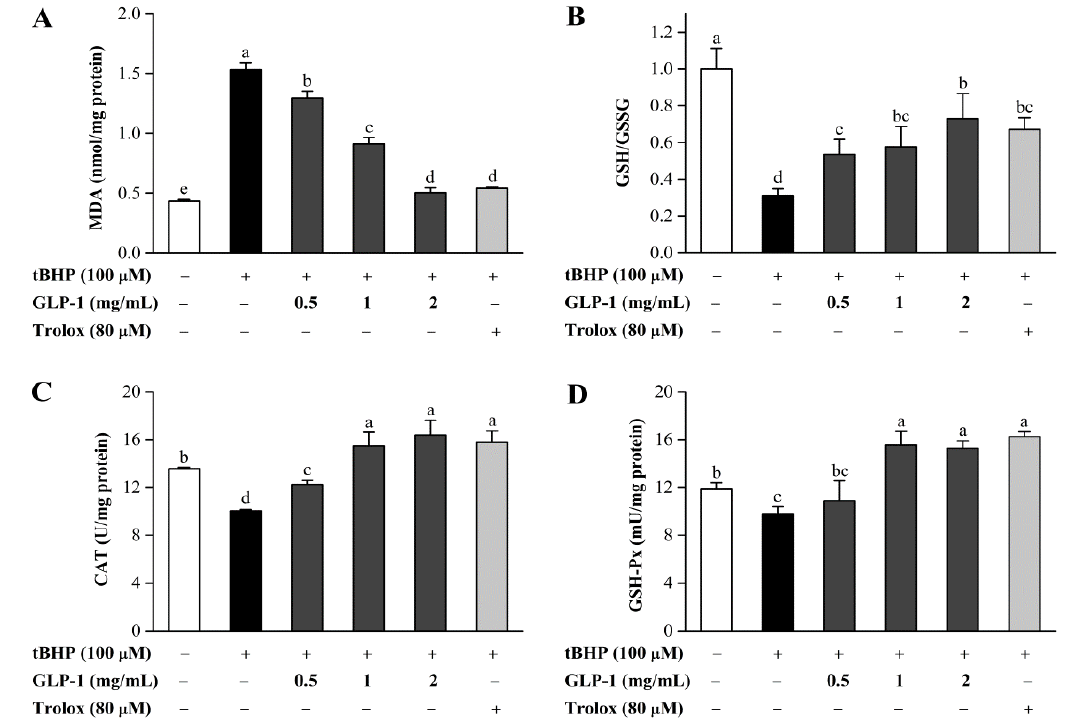
Figure 7. Effects of GLP-1 on MDA level ( A ), GSH/GSSG ratio ( B ), CAT ( C ), and GSH-Px ( D ) activities in tBHP-treated NIH3T3 cells. Data are presented as mean ± S.D. Values with different letters (a–d) denote the significant differences ( p < 0.05).